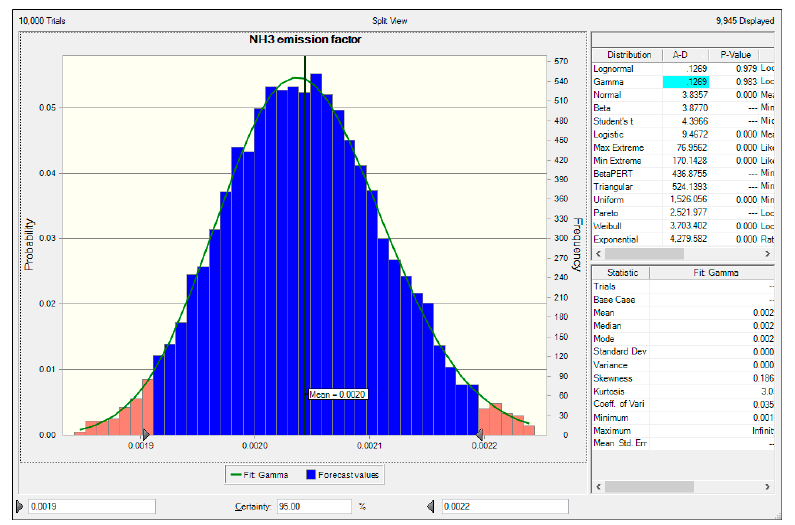
Figure 3. Process of the Monte Carlo simulation for estimating the uncertainty of the NH 3 emission factor.